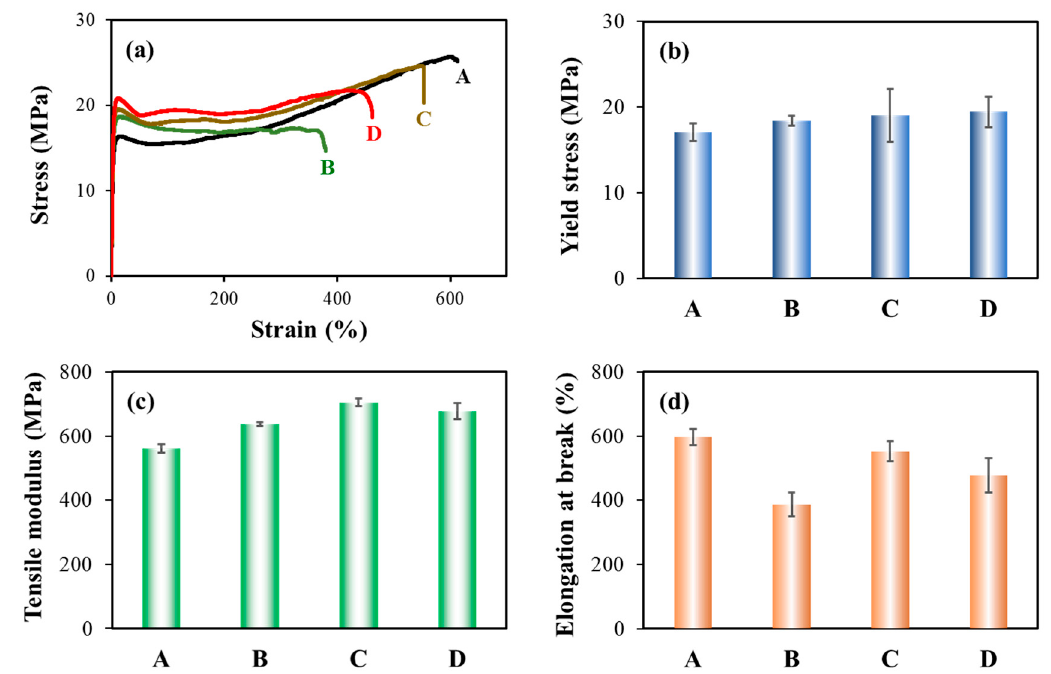
Figure 7. Tensile properties of the injection-molded foams with a 2-fold expansion ratio: ( a ) typical stress–strain curves; ( b ) yield stress; ( c ) elongation at break; and ( d ) tensile modulus of (A) iPP, (B) CNF-0, (C) CNF-0.2 and (D) CNF-0.4 specimens.